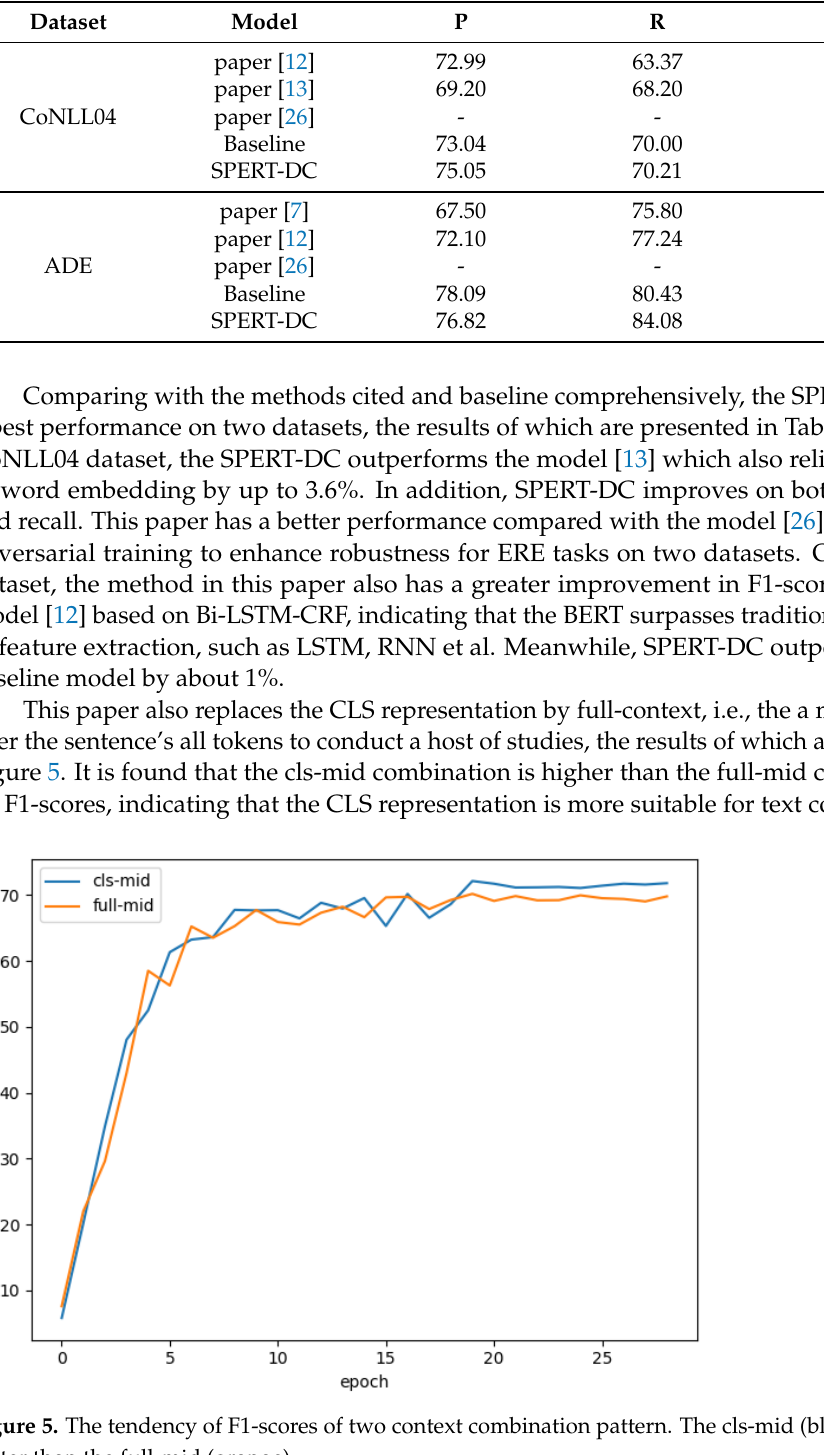
Table 2. The detal in result of experiments. The best results for all datasets are marked with bold font.